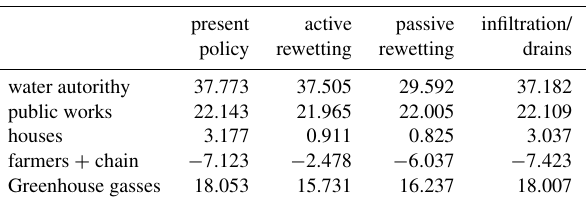
Table 4. Main results in EUR million per year for the period 2016– 2100. The table shows yearly costs, but yearly profits if the figures are